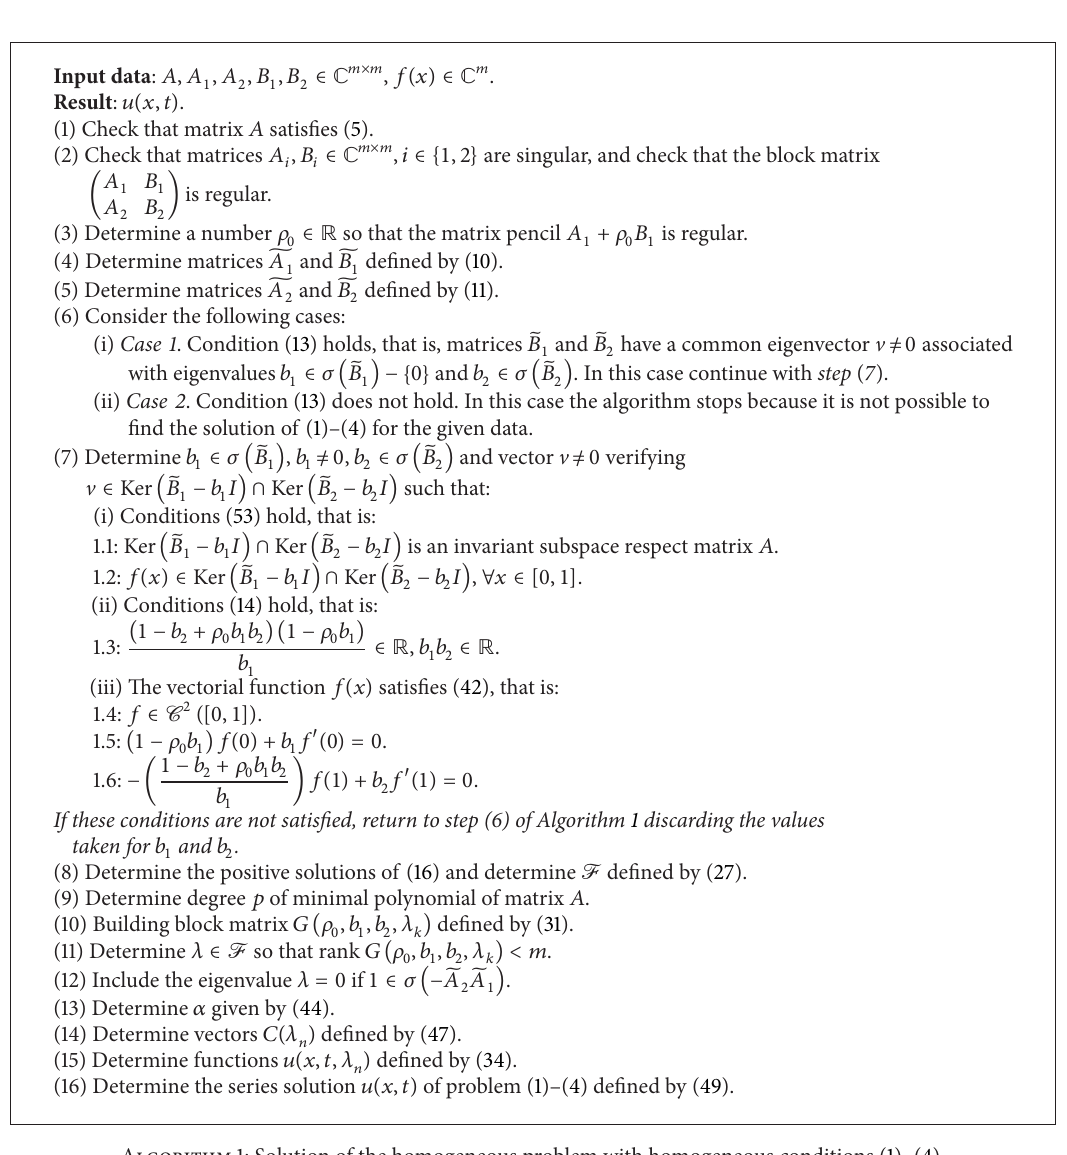
Algorithm 1: Solution of the homogeneous problem with homogeneous conditions